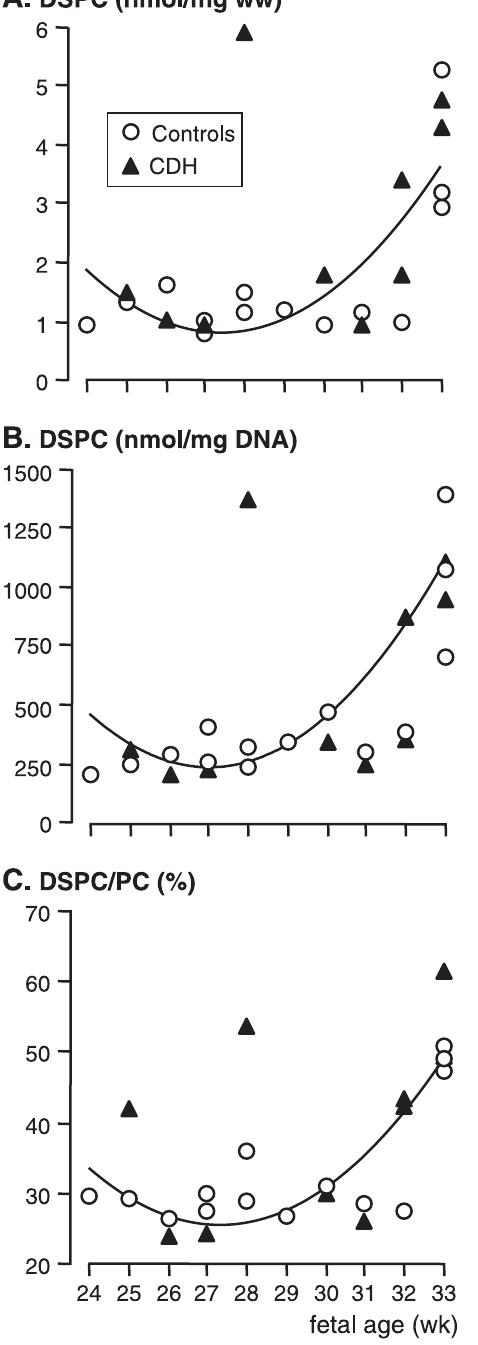
Figure 1. DSPC in Human Fetal Lungs DSPC was normalized to lung wet weight (ww) (A) and lung DNA (B), and expressed as a ratio of DSPC to total PC (i.e., DSPC plus unsaturated PC) (C). A rise in DSPC concentration and in the ratio of DSPC to total PC, which is indicative of an enhanced rate of surfactant accumulation, was observed at fetal age 32–33 wk in CDH as well as in control fetal lungs. There were no differences in the data between the groups, whatever the considered fetal age. DSPC displayed the same exponential increase in control lungs and CDH lungs with fetal age ( p -value for quadratic term , 0.01).